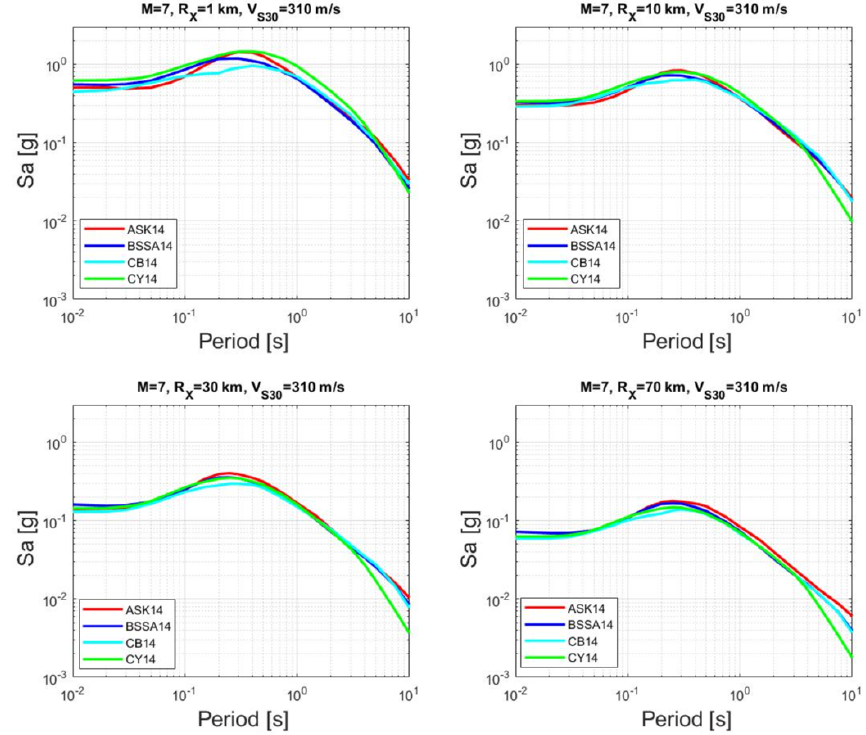
Figure 11. Median response spectra predicted by the global candidate GMPEs for vertical strike–slip earthquakes with V S30 = 310ms − 1 at selected epicentral distances ( R X ) . Sa named as an abbreviation of spectral